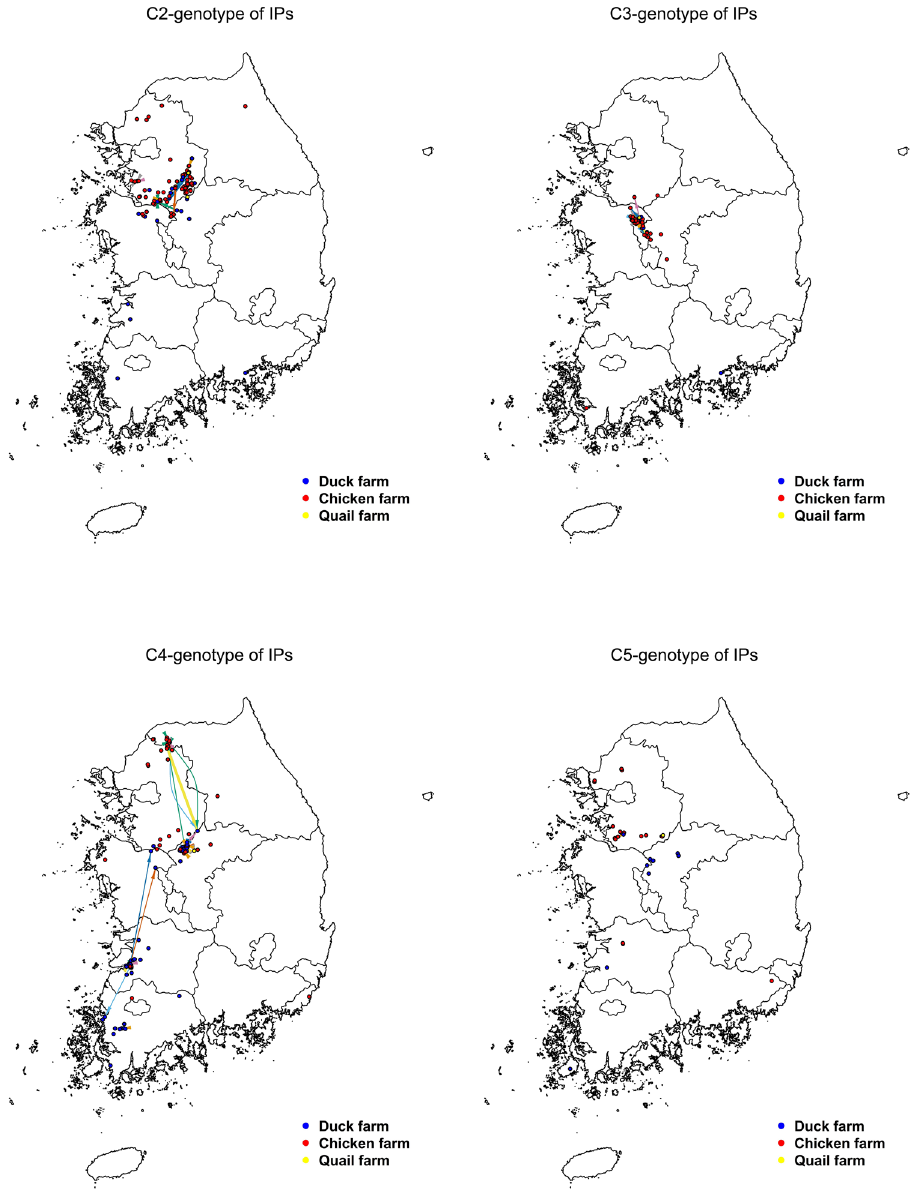
Figure 2. The geographical contact network between the same HPAI H5N6 genotype of infected premises (IPs) constructed under temporal infectious duration of IPs and vehicle movement based on Bayesian inference; C2(top left), C3(top right), C4(bottom left) and C5(bottom right). Blue dot denotes a duck farm, red dot points out a chicken farm and brown dot represents quail farm. The color of edges represented an individual vehicle